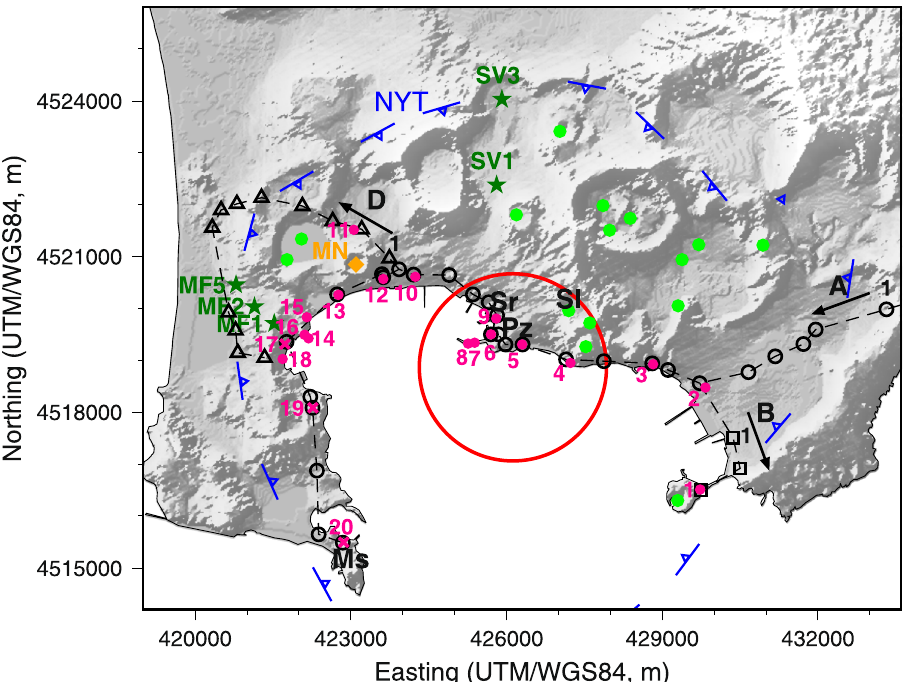
Figure 1. Campi Flegrei caldera. Green dots, third epoch vents; MN, Monte Nuovo (1538 AD eruption); Pz, Pozzuoli; Ms, Miseno; Sr, Serapeo; Sl, Solfatara; black symbols, levelling benchmarks; magenta dots, 1400–1536 data sites 11 ; dark green stars, AGIP boreholes 28 ; red circle, surface projection of the ~3600 m deep sill used in this work. A, B and D and related dashed lines indicate levelling routes in Fig. 2. (Map generated using GMT v. 4.5.12, http://gmt.soest.hawaii.edu/; relief from a 20-m Digital Elevation Map freely provided by the Italian Istituto Superiore per la Protezione e la Ricerca Ambientale, http://www.sinanet.isprambiente.it/it/sia-ispra/